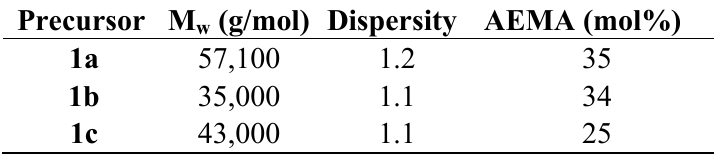
Table 1. Characteristics of different precursors of ultra-small PMMA-NPs synthesized by reversible addition-fragmentation chain transfer (RAFT)